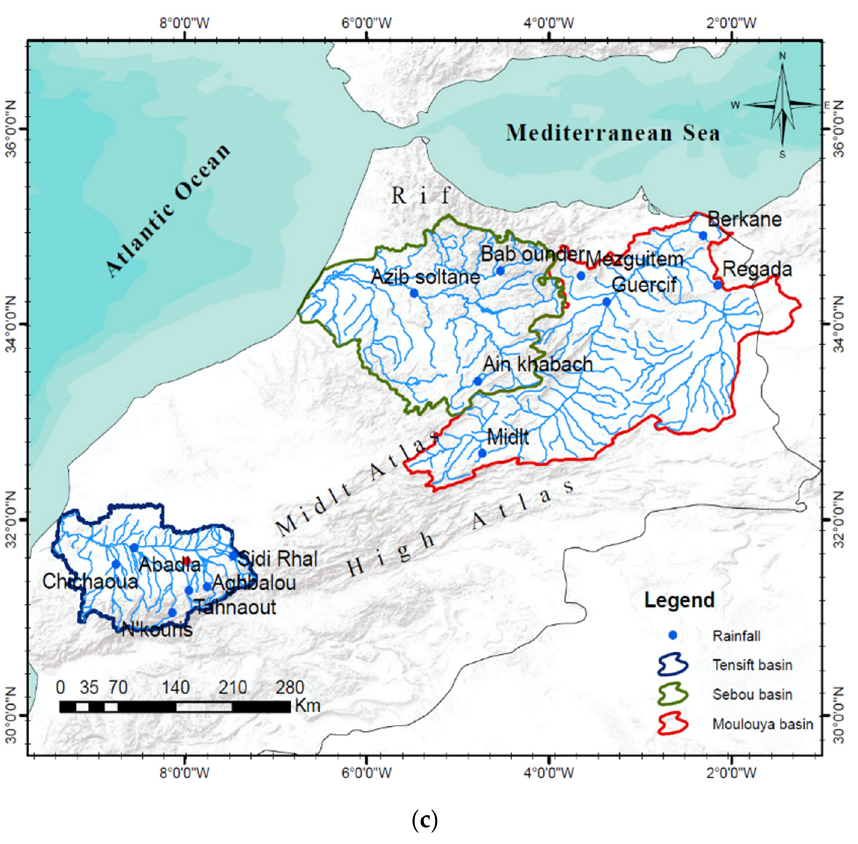
Figure 2. ( a ) Positioning of rainfall stations, ( b ) gridded data and ( c ) runoff station positions in the study area. Table 2. Hydrometeorological stations used.